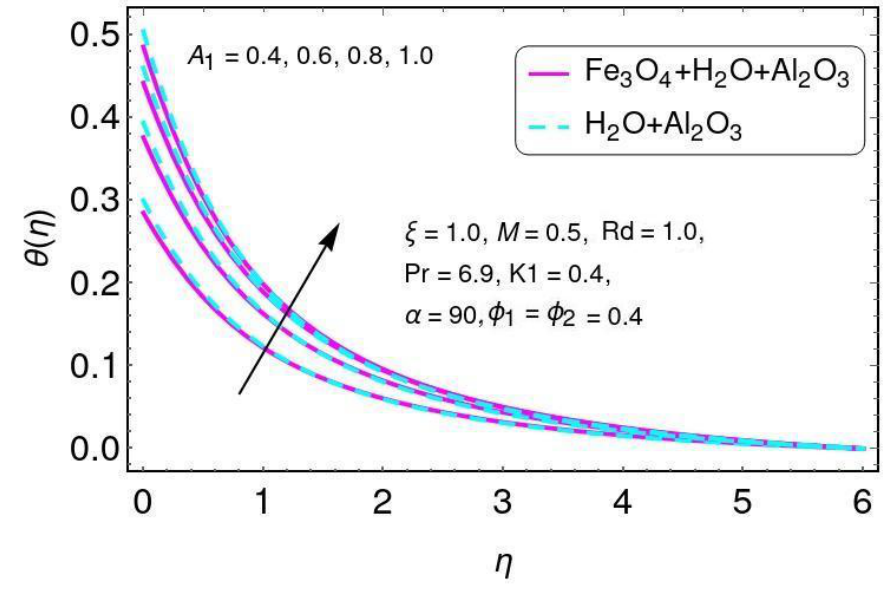
Figure 14. The properties of A 1 on the temperature